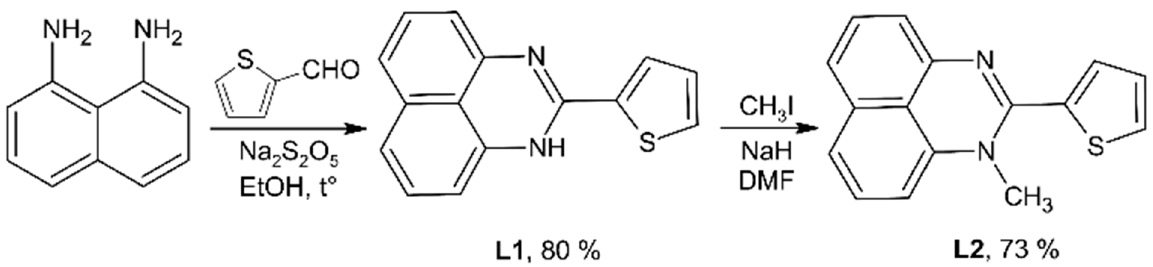
Scheme 1. Preparation of